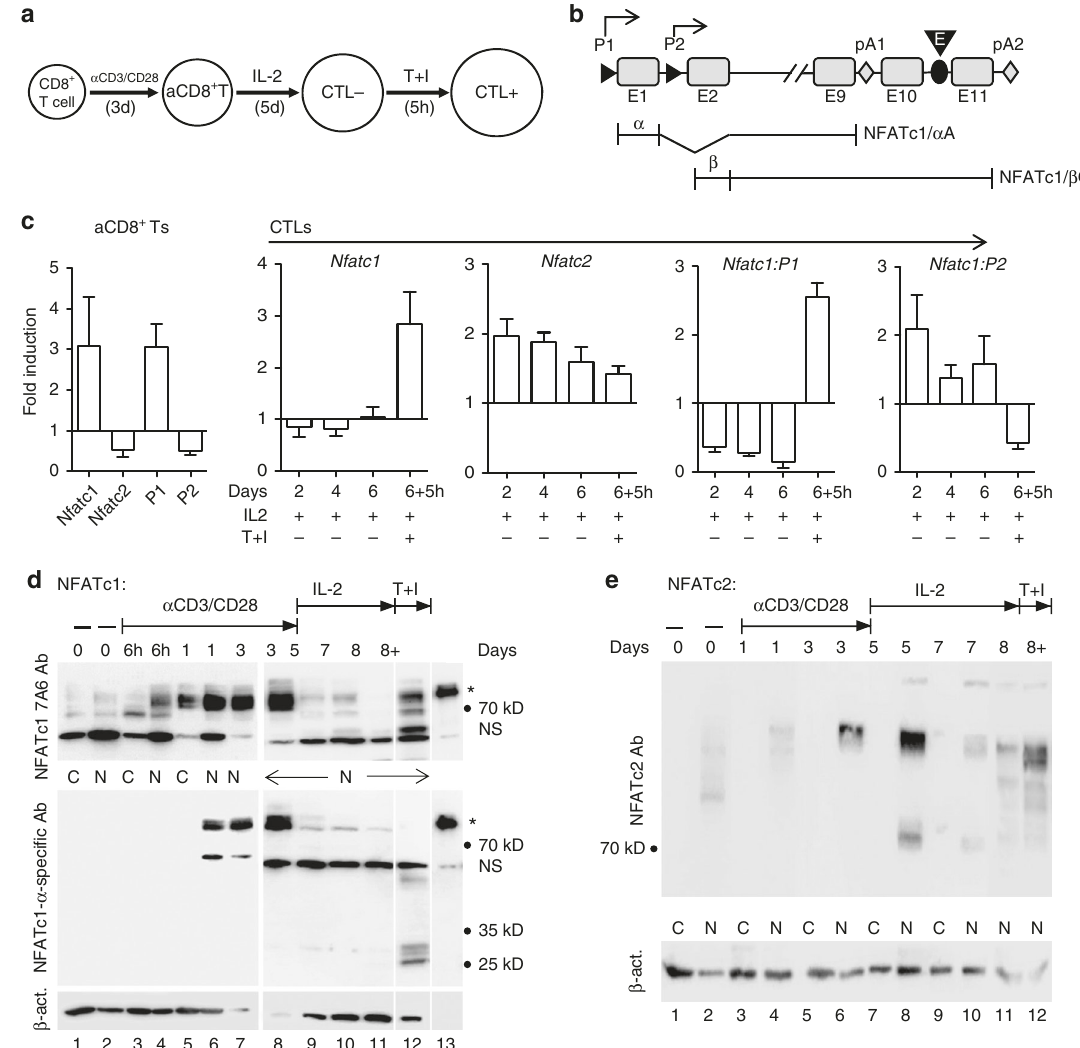
Fig. 3 NFATc1 induction in murine CD8 + T cells. a Scheme of generation of aCD8 + Ts and CTLs from splenic CD8 + T cells in vitro. b Scheme of the murine Nfatc1 gene 67, 68 . P1, P2, promoters; pA1, pA2, polyadenylation sites; E, intronic enhancer. c Induction of the Nfatc1 and Nfatc2 genes at the transcriptional level. RT-PCR assays, normalized by Actb and relative to naïve CD8 + T cells. Left, NFATc1 and c2 RNA levels in CD8 + T cells, upon stimulation by α CD3/CD28 for 3 d. Right, RNA levels in CTL + cells incubated with α CD3/CD28 for 3 d followed by incubation for 2, 4 and 6 d with 100 U/ml IL-2, and for 6 d IL-2 and T + I for 5 h. d Immunoblot assays for the detection of NFATc1 ( upper blot) and NFATc1/ α A ( middle blot) in aCD8 + Ts and CTLs. As loading control, the blot was also incubated with an Ab against β -actin. CD8 + T cells were left untreated ( lanes 1 + 2 ) or treated by α CD3/CD28 for 6 h ( 3 + 4 ), 1 d ( 5 + 6 ) or 3 d ( 7 + 8 ). In lanes 9-11 , aCD8 + Ts treated with α CD3/CD28 for 3 d were maintained for 2 d ( lane 9 ), 4 d ( 10 ) and 5 d ( 11 ) in medium containing 100 U/ml IL-2. In lane 12 , in addition, CTLs were treated with T + I for 5 h. In lanes 13 , NFATc1/ α A stably expressed in KT12 cells was fractionated as marker. C, N, cytosolic and nuclear proteins. e Immunoblot for the detection of NFATc2. CD8 + Ts were treated and processed as in d . Typical blots of more